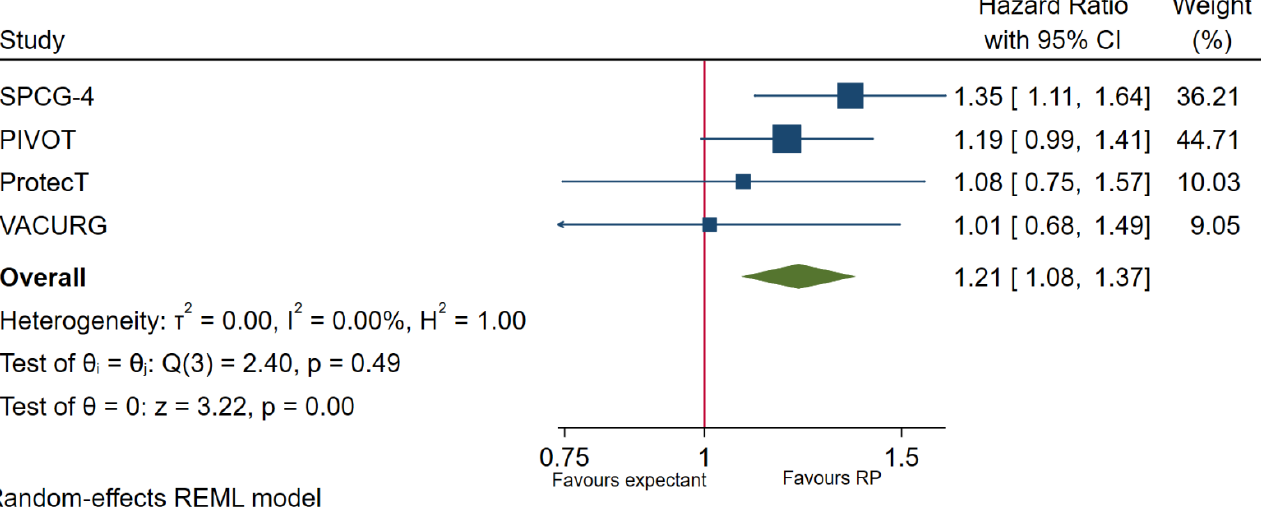
Figure 3. Cancer-specific survival in expectant management versus immediate RP. 3.2.2. Outcomes Stratified by Risks Only two trials stratified patient outcomes into low-risk, intermediate-risk and high risk. The different classifications of risks are reported in Supplementary Table S1. In low- risk patients, OS is similar between those undergoing expectant management and imme- diate RP (HR 1.31, 95% CI 0.80 – 2.16, p = 0.29; Supplementary Figure S5a), despite the SPCG-4 trial having significantly more T2 patients. Similarly, CSS is similar in the two group of low-risk patients undergoing expectant management or immediate RP (HR 1.31,